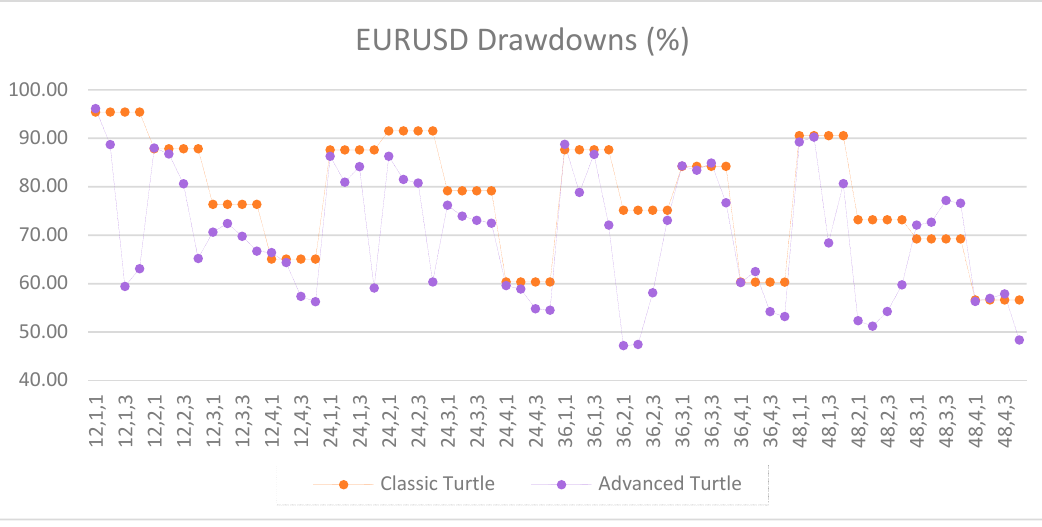
Figure A4. Drawdowns of EURUSD as percentage of equity between the classic and the advanced Turtle systems for every combination of N, X, Y for the fast parameters (20, 40).